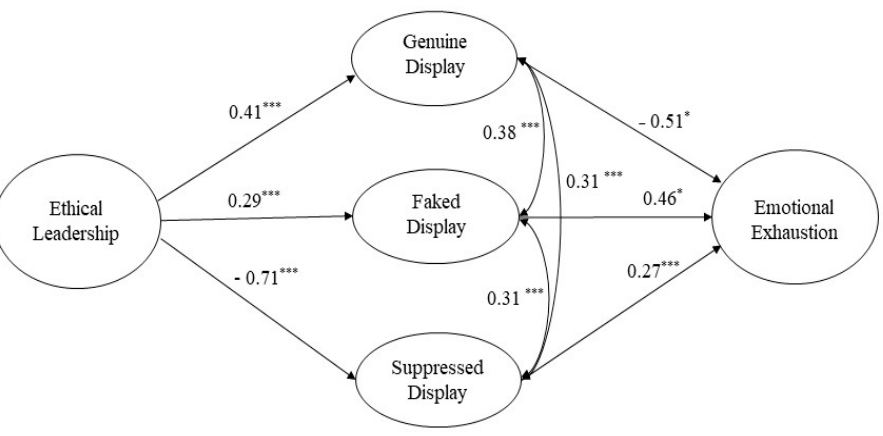
Figure 1. Structural model with standardized effects. Note. * p < 0.05, *** p < 0.001, fit indi-